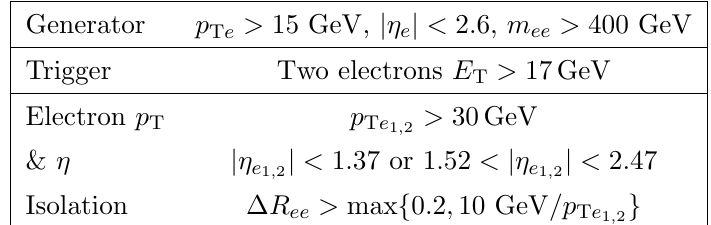
Table 2. Summary of basic cuts for the ATLAS DY ee search [18].